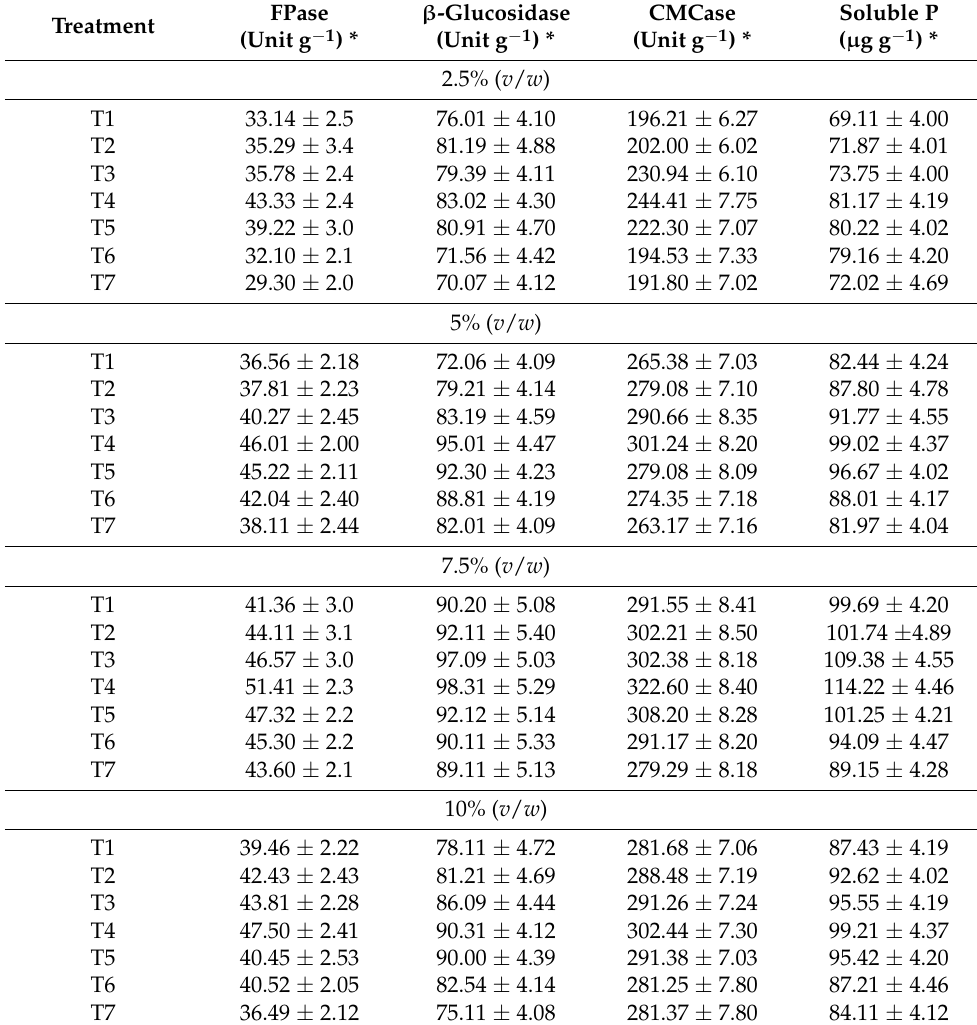
Table 5. Effects of different inoculum ratios on cellulase production and P solubilization by A. japonicus under different ratios of sugarcane bagasse and faba bean straw residues after the fourth week. β -Glucosidase FPase CMCase Treatment (Unit g − 1 ) * (Unit g − 1 ) * (Unit g − 1 )